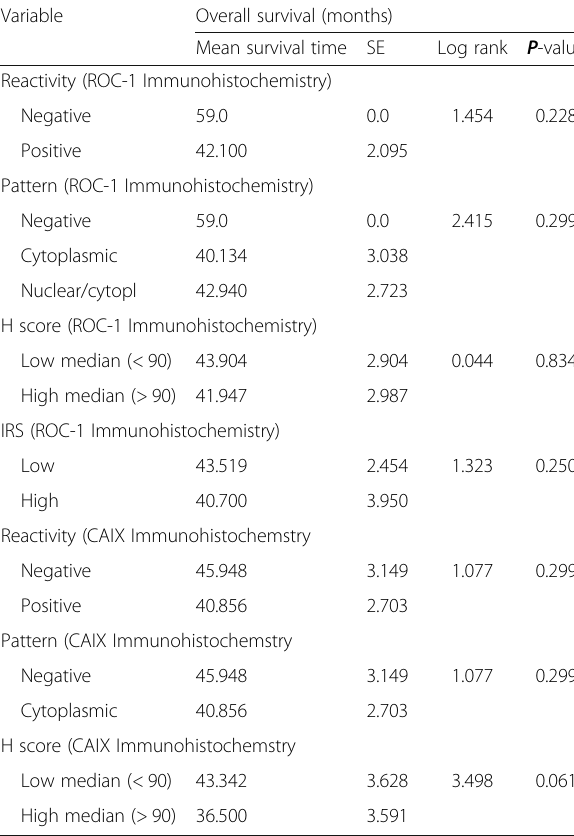
Table 6 Univariate survival analysis for studied bladder carcinoma cases